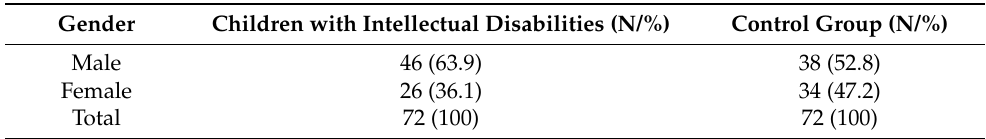
Table 1. Gender distribution of examined children.